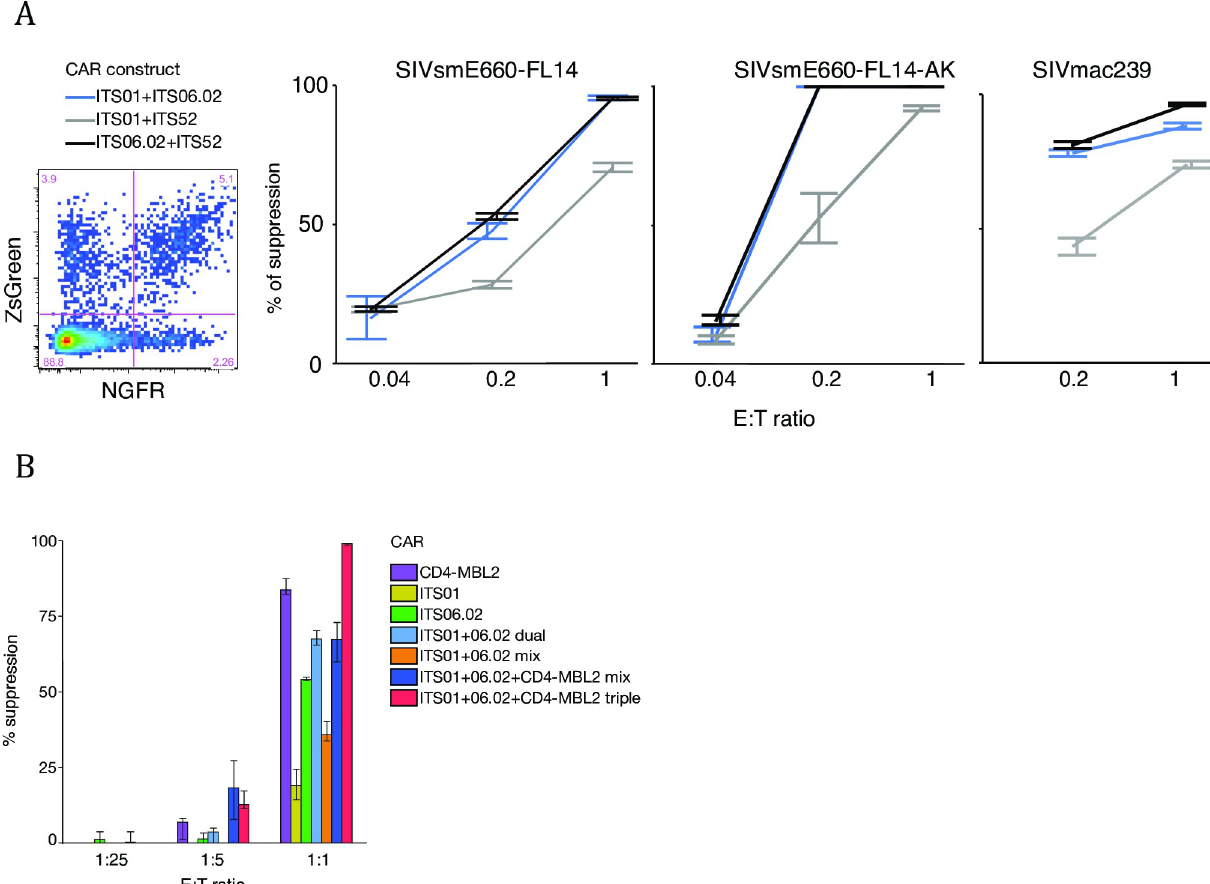
Fig 4. Viral suppression activity by dual and triple anti-SIV CAR T cells. (A) Dual anti-SIV-CAR transduction and viral suppression by dual anti- SIV-CAR T cells. Two different CAR vectors labeled with different reporter genes were mixed, coated on the same plates and transduced simultaneously. NGFR was stained with anti-NGFR-specific antibody and ZsGreen+NGFR+ cells were sorted for effector cells. Blue lines show suppression by ITS01 (CD4bs)+ITS06 (V1), grey lines show suppression by ITS01 (CD4bs)+ITS52 (V3) and black lines show suppression by ITS06.02 (V1)+ITS52 (V3) dual SIV-CAR T cells. Viral suppression on all tiers of SIV was assessed in duplicate. (B) Comparison of viral suppression efficacy based on valency. ITS01, ITS06.01 and/or CD4-MBL CAR were transduced to T cells separately or simultaneously. Single, dual or triple CAR T cells were sorted based on reporter gene or CAR expression. Sorted CAR T cells were co-cultured with SIVsmE660-FL14-infected cells in four replicates at E:T ratios of 1:1, 1:5 and 1:25. Percent reduction of p27-positive cells from CAR-negative samples were shown in the graph. E:T ratio at 0.04 was not performed for SIVmac239 due to shortage of CAR T cells for this